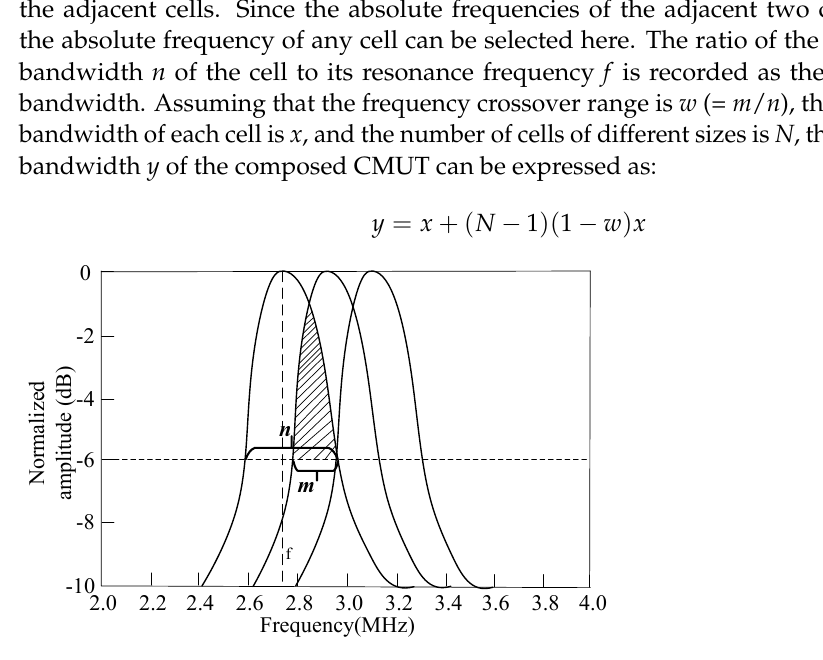
Figure 13. CMUT made up of different cell sizes.